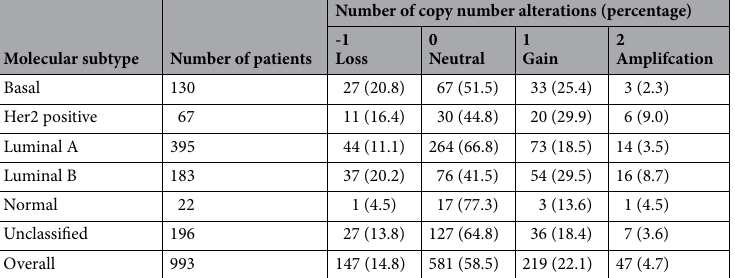
Table 5. Copy number alterations in RHOD in The Cancer Genome Atlas according to molecular subtype.